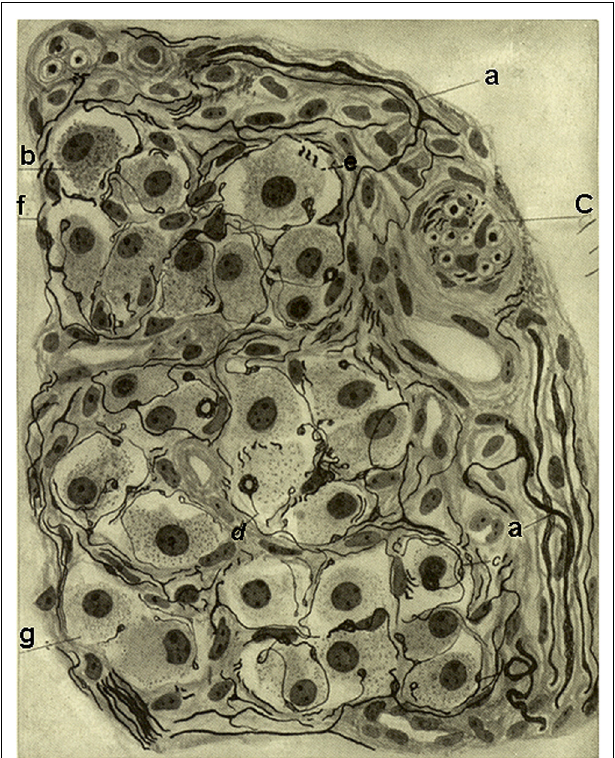
FIGURE 2 | Segment of a glomerulus of the intercarotid gland (the CB) of a young man. c, nerve with myelinated and unmyelinated fibers; a, division of myelinated fibers; b, glandular(chemoreceptor) cell; e, glandular cell with a nerve ending in mallet; g, another cell with vacuolated cytoplasm; f, fiber with varicosities; d, nerve ending forming a thick ring. Stained by the Cajal’s reduced silver nitrate method (in de Castro, 1926; courtesy of Fernando-Guillermo de Castro from the Archive Fernando de